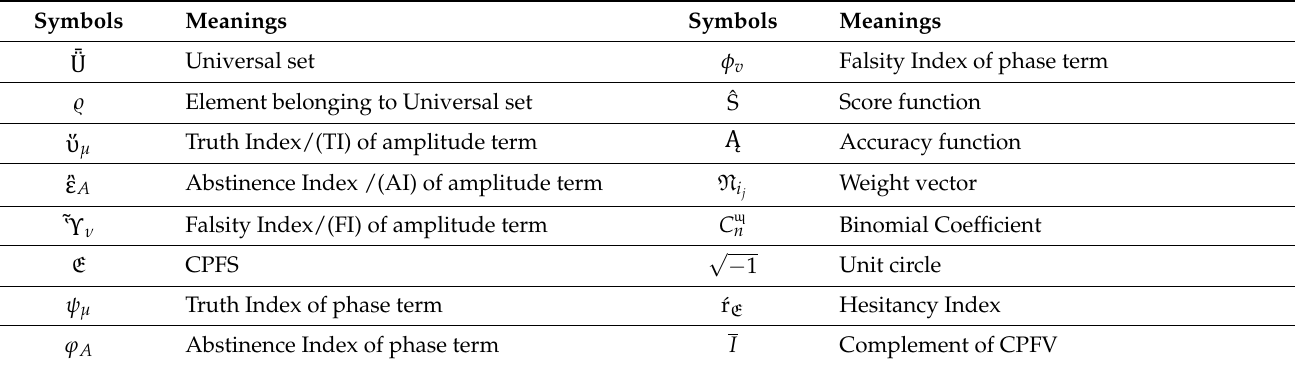
Table 1. Symbols and their meanings.